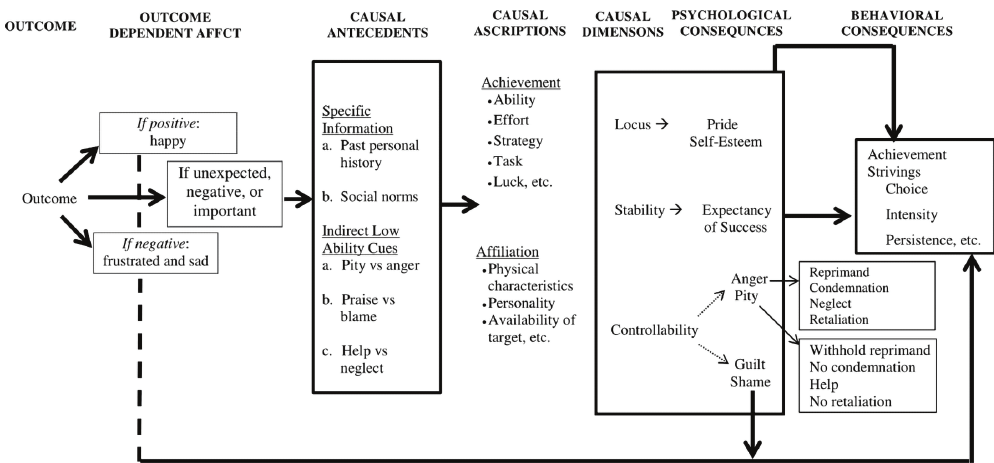
Figure 1. Weiner’s (1986) Attribution